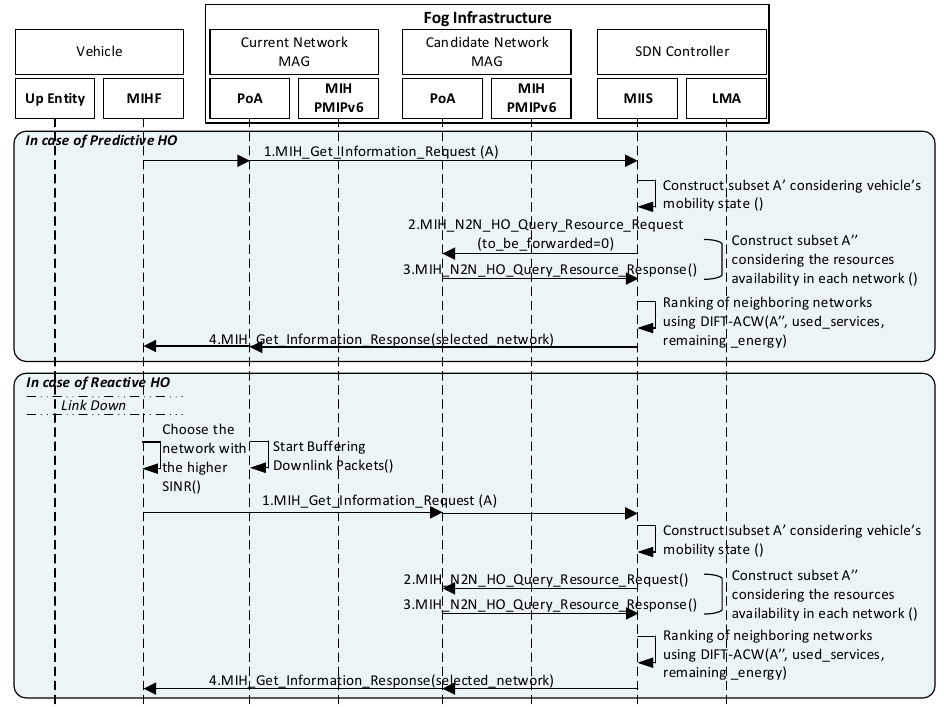
Figure 8. The signaling performed during the network